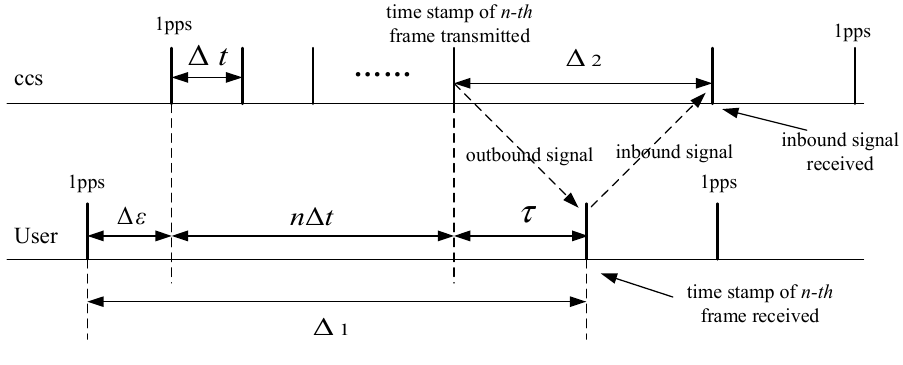
Figure 2. The two-way timing principle.